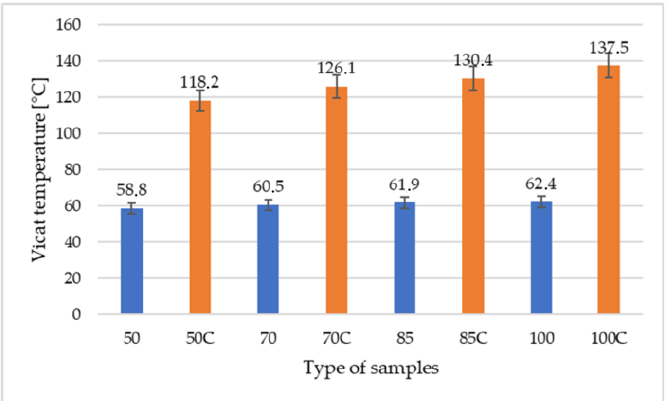
Figure 1. Comparison of the impact of the percent of added infill on Vicat Temperature.